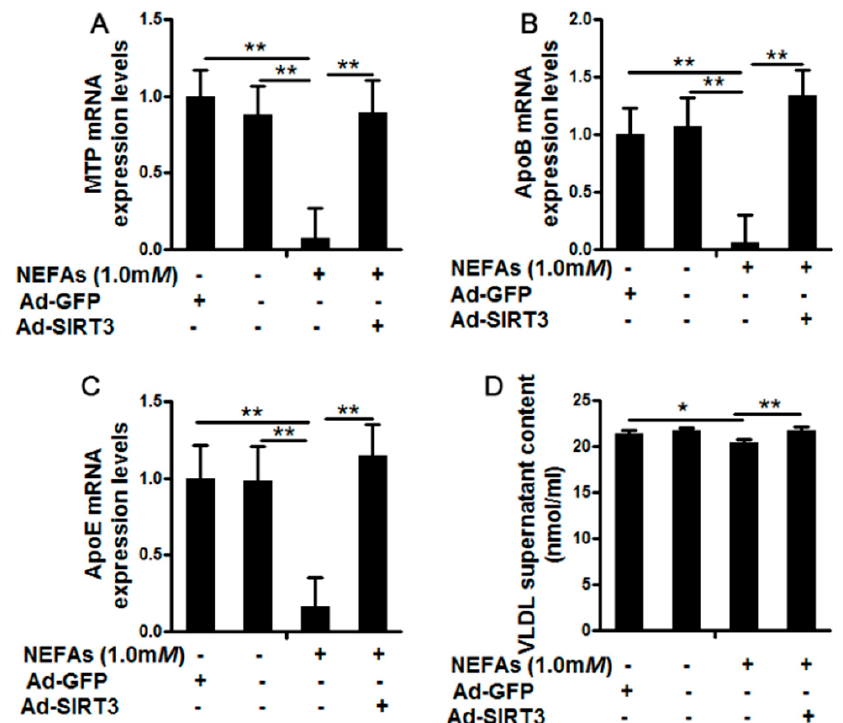
Figure 3. Effects of SIRT3 overexpression on the synthesis and secretion of Very Low-Density Lipoprotein (VLDL) in cow hepatocytes treated with nonesterified fatty acids (NEFA). Primary cow hepatocytes were treated with Ad-SIRT3 at 100 MOI for 30 h, serum starved for 6 h, and then treated with 1.0 m M NEFA for 12 h before cell harvest. Hepatocytes treated with Ad-GFP were used as the negative controls. The blank controls were hepatocytes incubated with RPMI1640 growth medium in parallel with the Ad-SIRT3 + NEFA group. The mRNA abundance of microsomal triglyceride transfer protein (MTP) ( A ), ApoB ( B ), and ApoE ( C ) were measured by qRT-PCR. The VLDL content in supernatants was measured by a commercial kit ( D ). For all bar plots shown, data are expressed as the mean ± SEM. * indicates p < 0.05; ** indicates p < 0.01 by the one-way ANOVA with Bonferroni correction. Results are representative of at least three independent